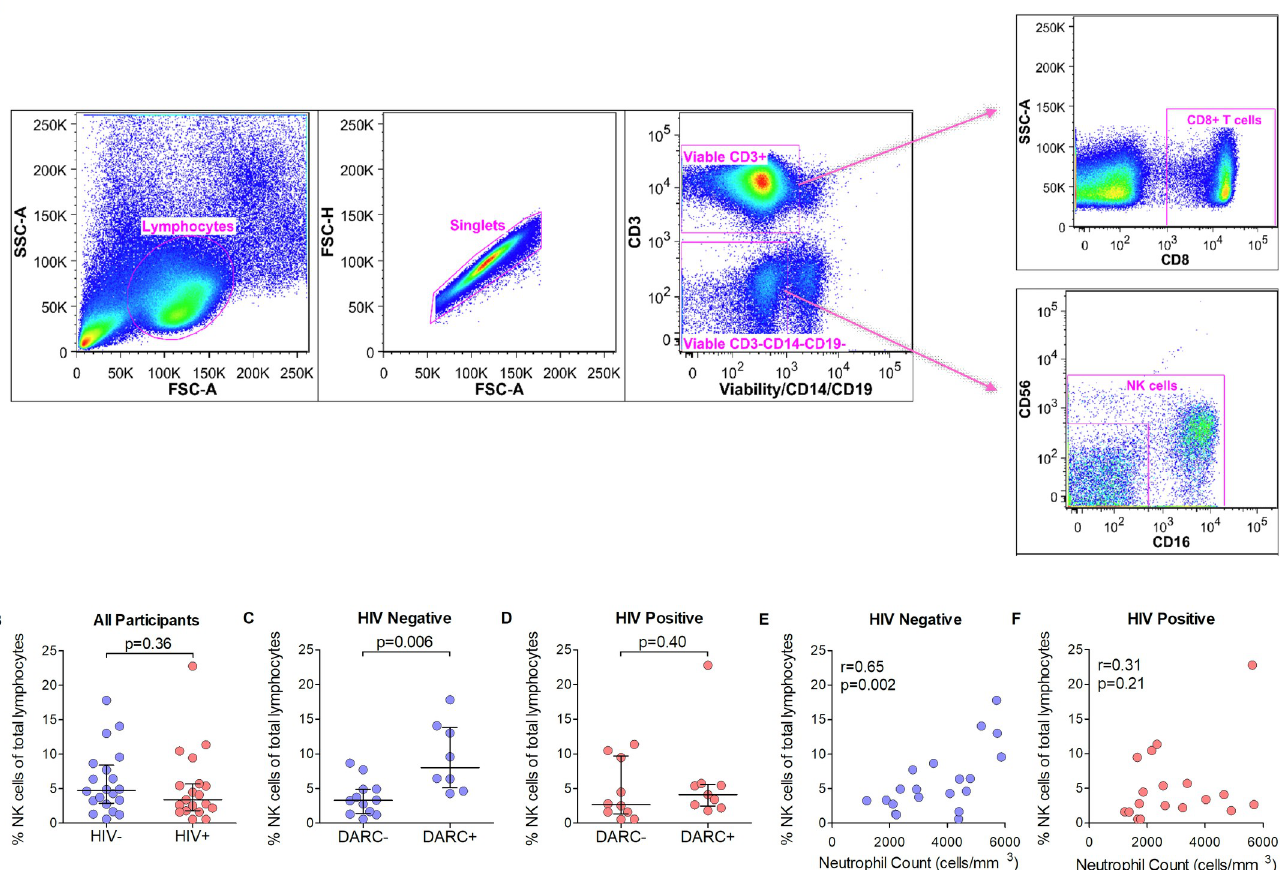
Fig 1. Total NK cell frequencies. (A) Representative gating strategy employed for the identification of total NK cells and CD8+ T cells from lymphocytes using multi-parametric flow cytometry. Side scatter area (SSC-A) vs forward scatter area (FSC-A) was used to identify lymphocytes followed by exclusion of doublets by forward scatter height (FSC-H) vs FSC-A, and exclusion of non-viable cells, B-cells and monocytes by use of viability dye and anti-CD19 and anti-CD14 monoclonal antibodies. Cytolytic T cells were identified using anti-CD3 and anti-CD8 monoclonal antibodies, whilst NK cells were identified as CD3 negative and CD56 positive and/or CD16 positive cells. (B) NK cell frequency as a percentage of total viable lymphocytes in all participants. NK cell frequency as a percentage of total viable lymphocytes stratified by DARC genotype in HIV negative (C) and HIV positive (D) individuals. Correlations between NK cells as a percentage of total lymphocytes and ANCs are shown in HIV negative (E) and HIV positive (F) individuals. Dots indicate individual data points. Medians are indicated and extended to interquartile range with whiskers. Abbreviations: DARC, Duffy antigen receptor for chemokines; ANC, Absolute neutrophil count; r, Spearman rho.